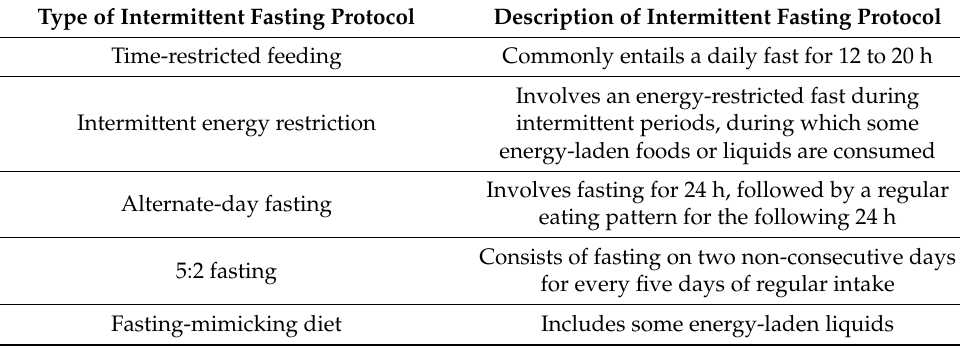
Table 1. Intermittent fasting protocols.